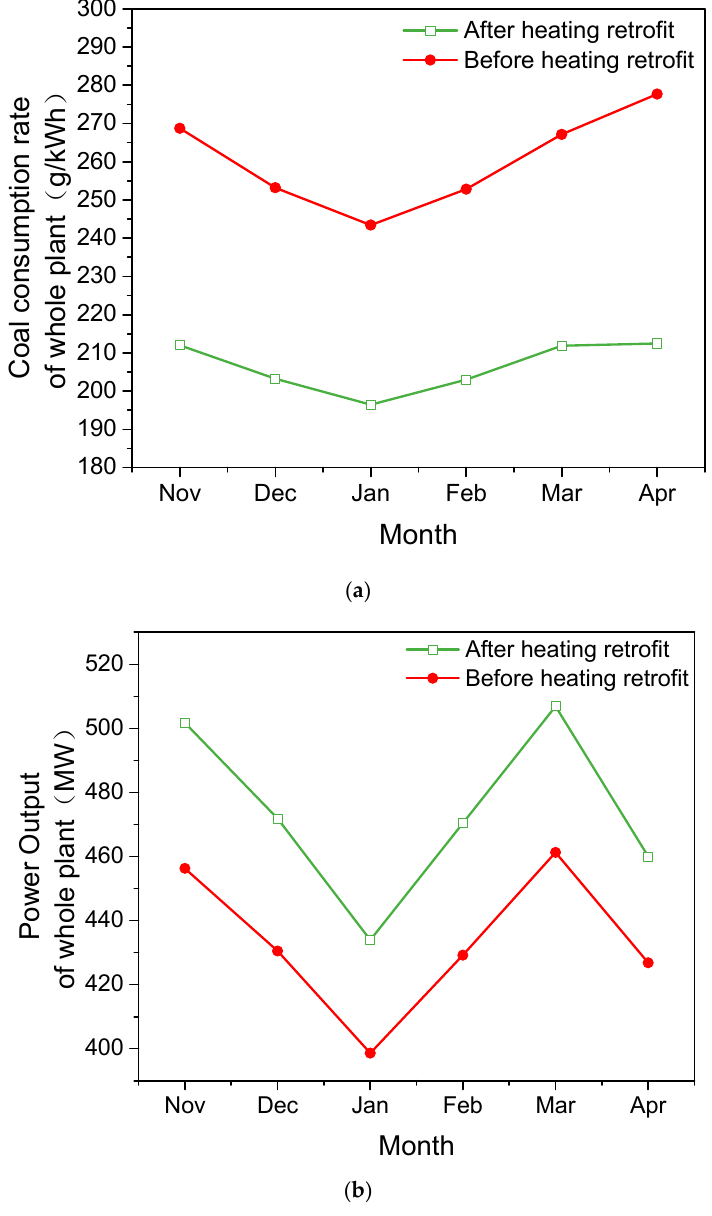
Figure 6. Comparisons of the performance of the power plant during the heating season before and after the retrofit. ( a ) Coal consumption rate; and, ( b ) Power output